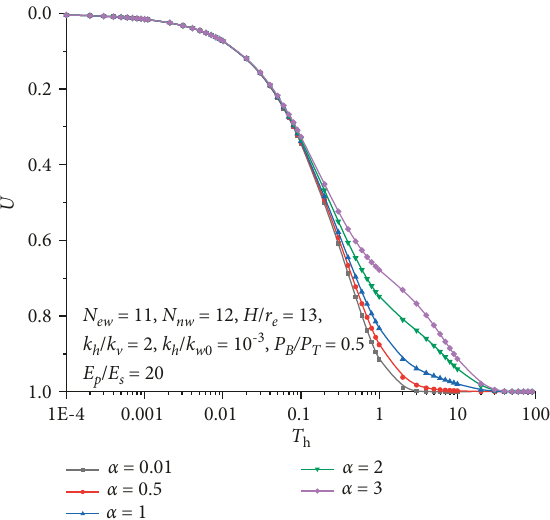
Figure 3: Consolidation curves for different distributions of initial pore